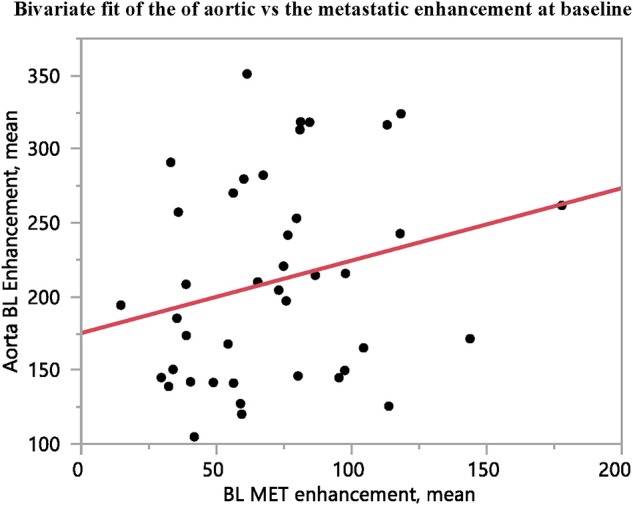
The contrast-enhancement in the abdominal aorta at the level of the coeliac trunk shows no correlation to the contrast-enhancement of the metastases at baseline (n = 41, R2 = 0.06, p = 0.12).